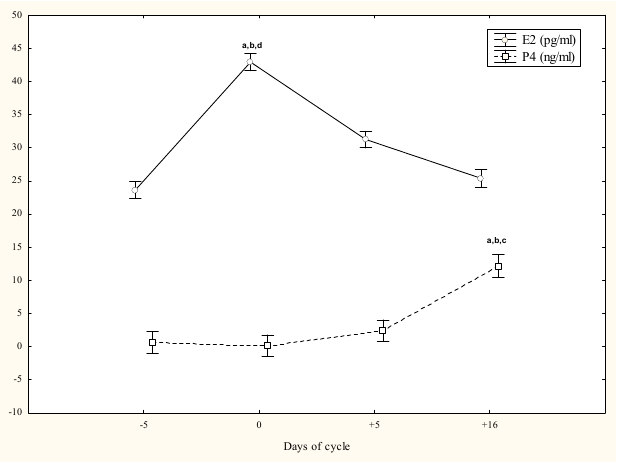
Figure 2. Circulating estradiol-17 β (E2) and progesterone (P4) concentrations (mean ± SD) in cycling Spanish Purebred mares. Letters indicate significant differences among days: a vs. − 5; b vs. 0; c vs. +5; d vs. +16 d ( p < 0.05). Table 2. Spearman’s coefficients among iron, ferritin, hepcidin, estradiol-17 β (E2), and progesterone (P4) in cycling Purebred Spanish mares.